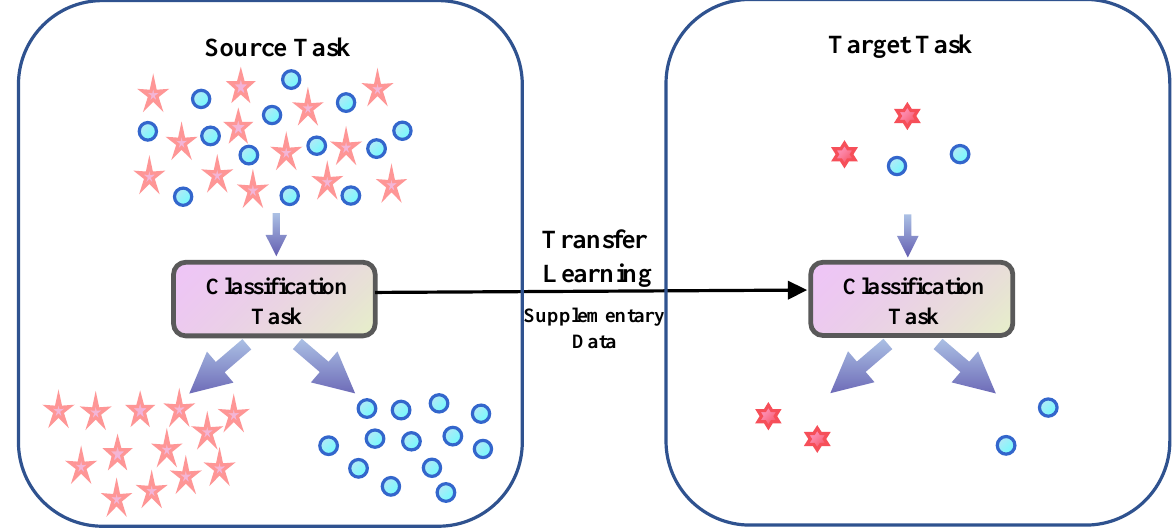
Figure 5. A simple illustration of transfer